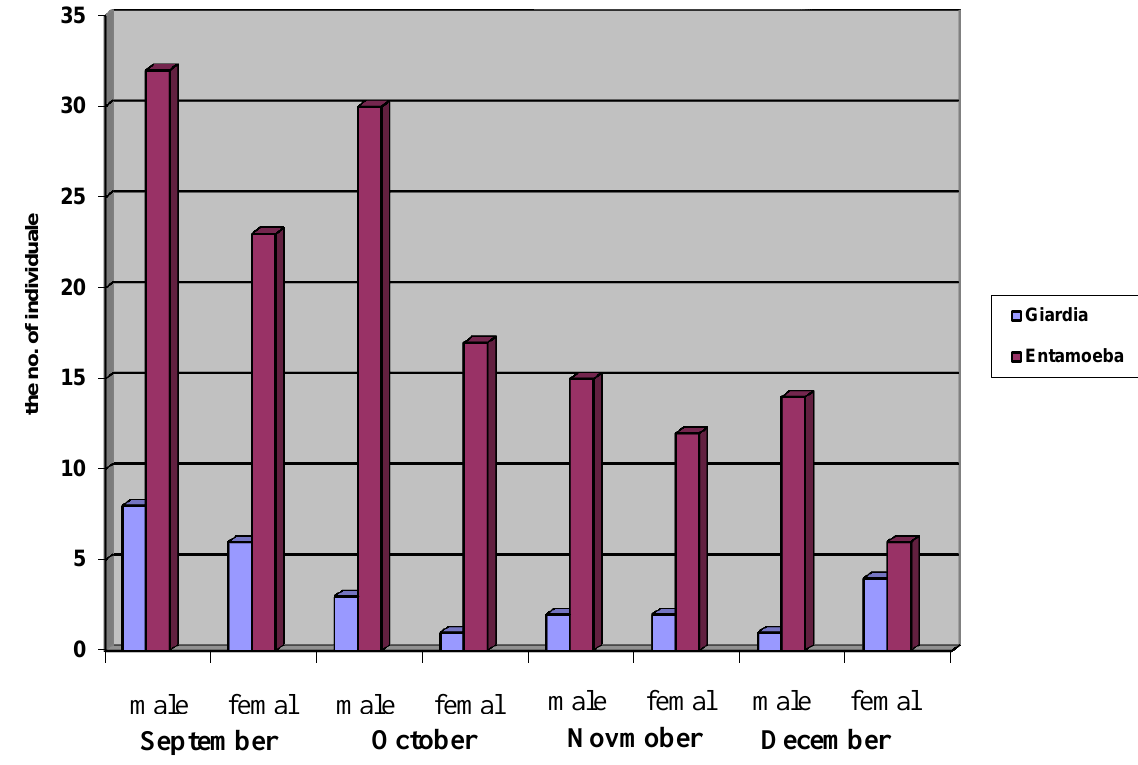
Figure (1): Distribution of Giardia lamblia and Entamoeba histolytica according to the gender from September – December 2010